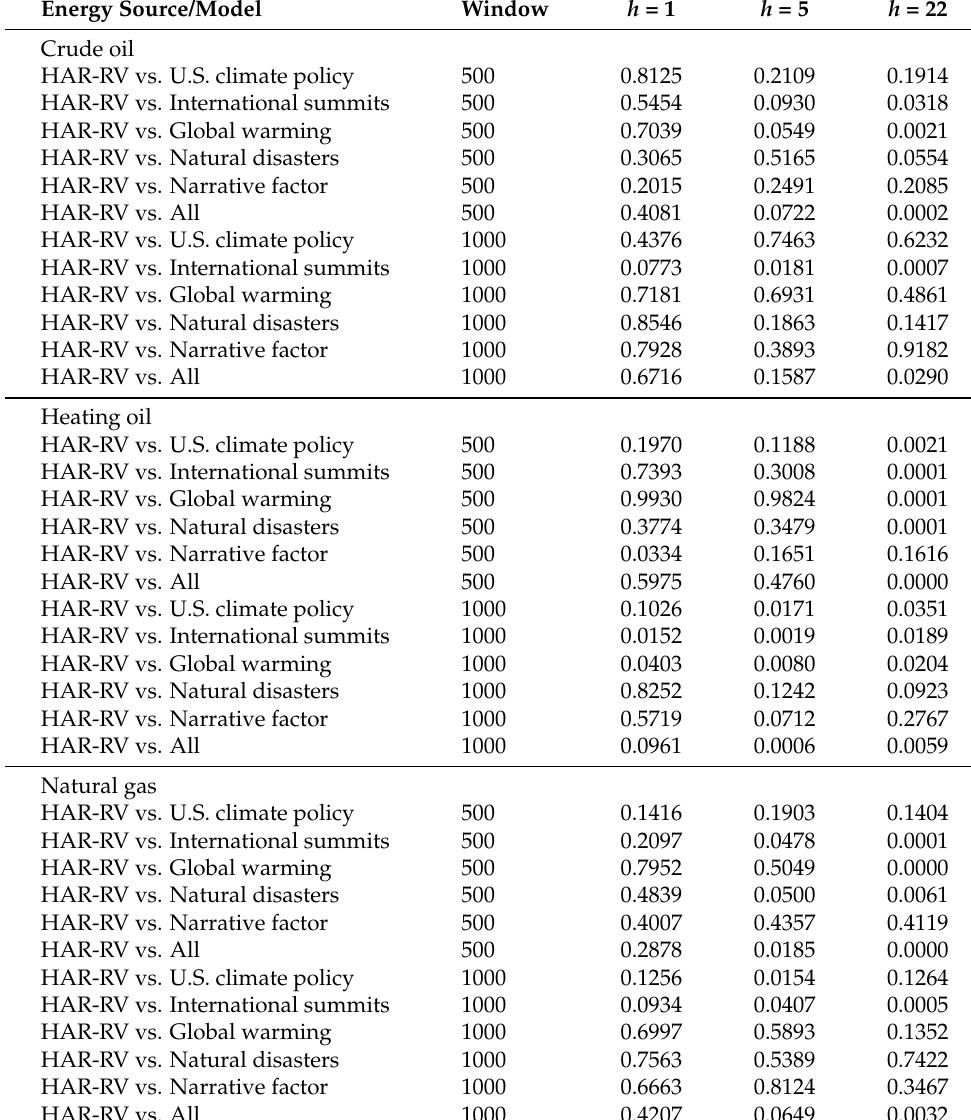
Table 6. Results for longer rolling-estimation windows. Results ( p -values; robust heteroskedasticity and autocorrelation consistent standard errors) of the Clark–West tests for an equal mean-squared prediction error are based on robust standard errors. The classic HAR-RV model is the benchmark model, and the model extended to include all climate-risk factors and estimated by the Lasso, Ridge, and elastic-net estimator is the rival model. The alternative hypothesis is that the rival model has a smaller MSPE than the benchmark model. The parameter h denotes the forecast horizon (in